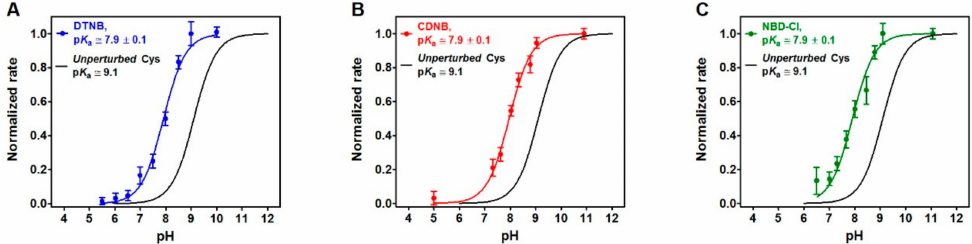
Figure 4. p K a determination. The rRNase (1.25 µ M) was reacted with 20 µ M of DTNB, CDNB, and NBD-Cl at variable pH values as reported under Materials and Methods. Average p K a = 7.9 ± 0.1 of the eight reactive cysteines in the rRNase was calculated using ( A ) DTNB, ( B ) CDNB, and ( C ) NBD-Cl (all curves were obtained by fitting to equation (2)). The theoretical curve of an unperturbed protein cysteine (p K a = 9.1) is reported in the three panels (black line). Data are the average ± SD of